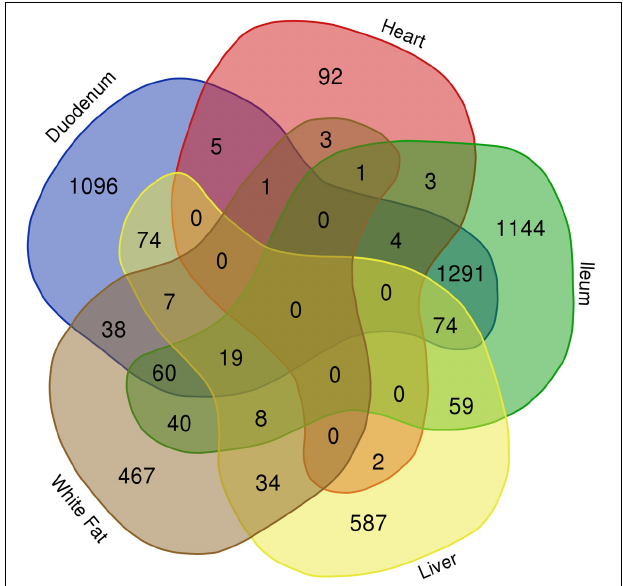
FIGURE 4 | Distinct transcriptional alterations in different organs of GF mice in normoxia. Little common changes were identified in the differentially expressed genes (DEGs) between the examined organs of the GF mice under normoxic condition, except a significant overlapping between the two gut segments (duodenum and ileum), demonstrating a distinct and organ-specific impact of microbiome on gene expression.